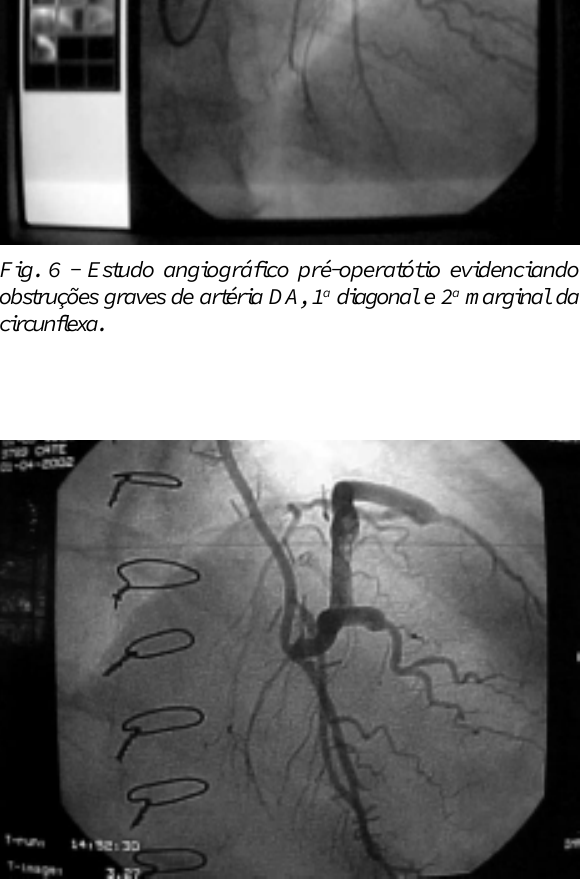
Fig. 7 - Ponte de ATIE para artéria DA; segmento de VSM da ATIE para 1 a diagonal; segmento de VSM oriundo do primeiro segmento venoso para a 2 a marginal da